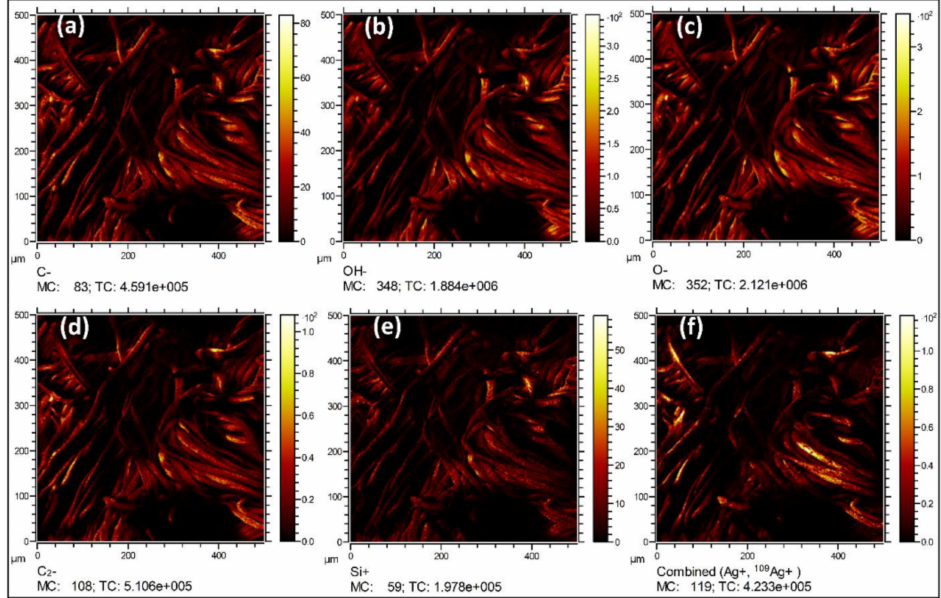
Figure 6. ToF-SIMS mapping of C-CA-RGO-Ag sample: the distribution of ( a ) C − , ( b ) OH − , ( c ) O − , ( d ) C 2 − , ( e ) Si + , and ( f ) Ag + elements (reprinted with permission from Ref. [33] Copyright 2022